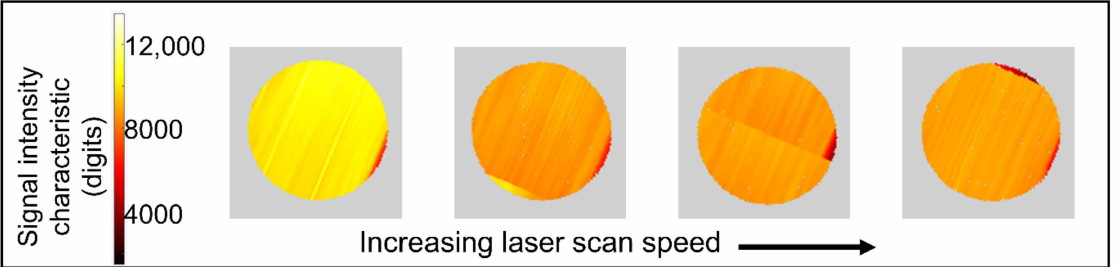
Figure 12. Signal intensity characteristics with increasing laser scan speed in the conduction regime, sampled from the topmost layer of each specimen. Laser scan speed 1000 mm/s, 1200 mm/s, 1400 mm/s, and 1600 mm/s and otherwise identical parameters (nominal laser power 300 W and layer thickness 40 µ